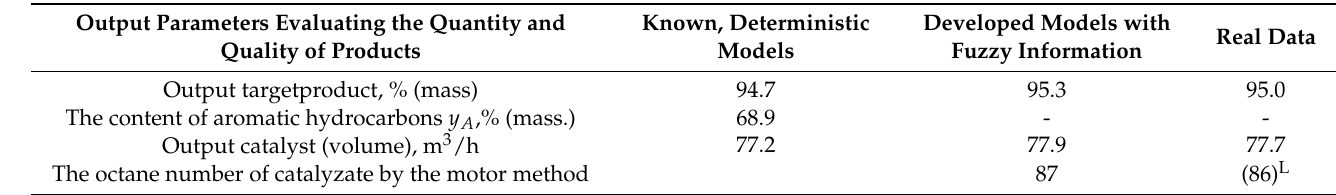
Table 2. Results of modelling based on known models [34], developed models taking into account fuzzy information and real data from the LG-35-11/300-95 unit of the Atyrau oil refinery factory. Output Parameters Evaluating the Quantity and Known, Deterministic Developed Models with Real Data Quality of Products Models Fuzzy Information Output targetproduct, % (mass)